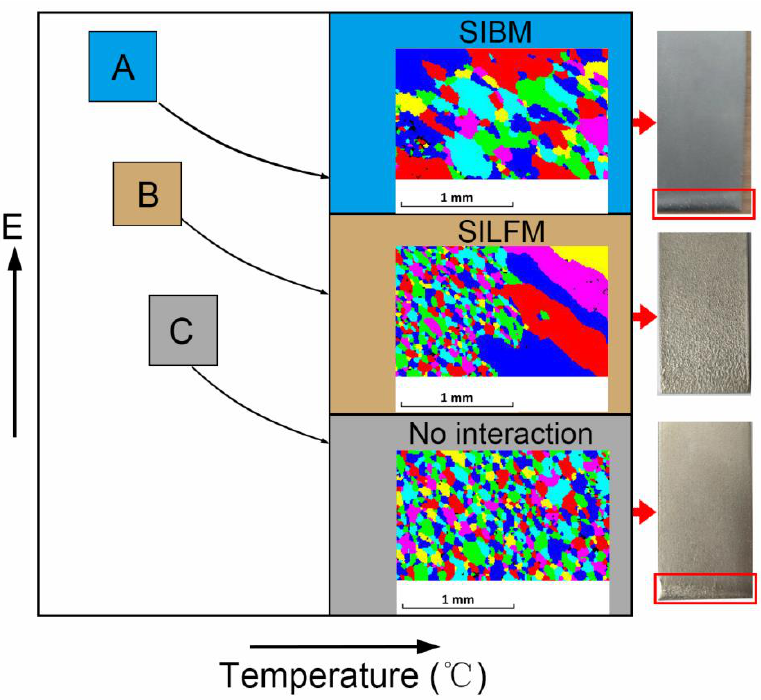
Figure 14. The microstructural evolution and the brazing performance of the two-layer Al sheets after fluidity test. A, B, C in the figure represent sample A, sample B and sample C.